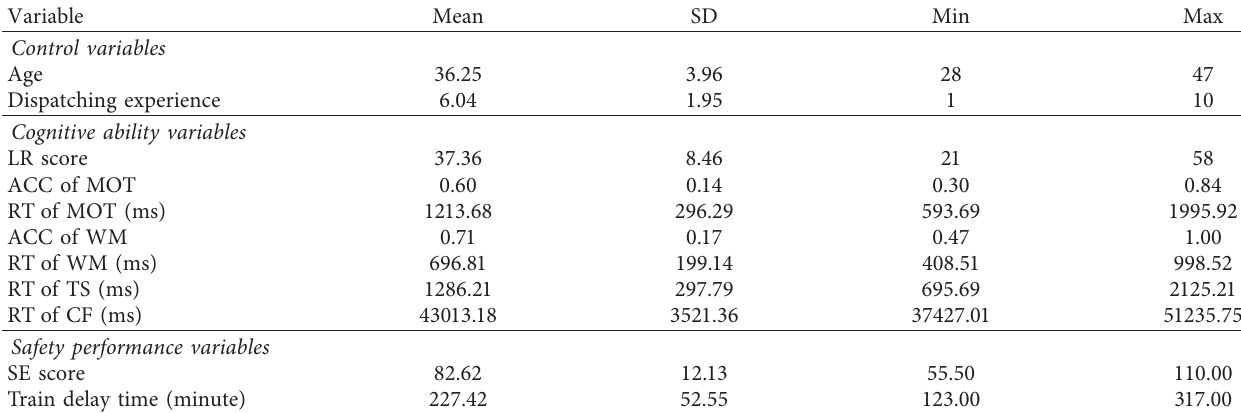
Table 2: Descriptive statistics of all variables ( n �